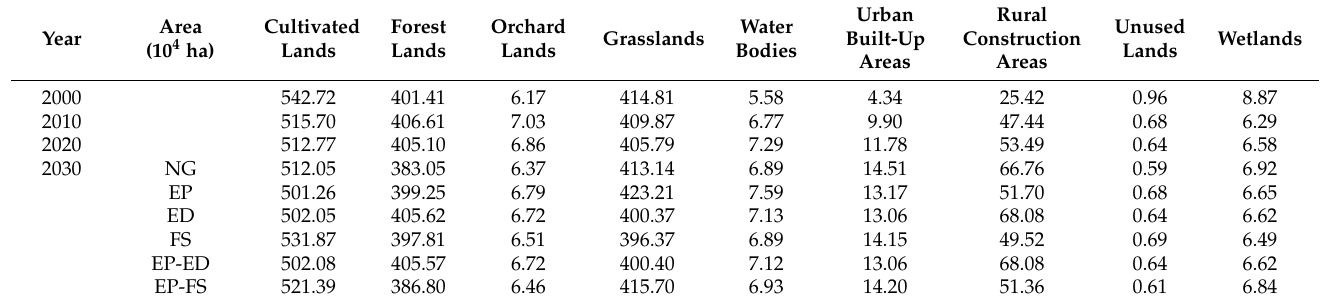
Table 5. The area and proportion of land use types under various scenarios from 2000 to